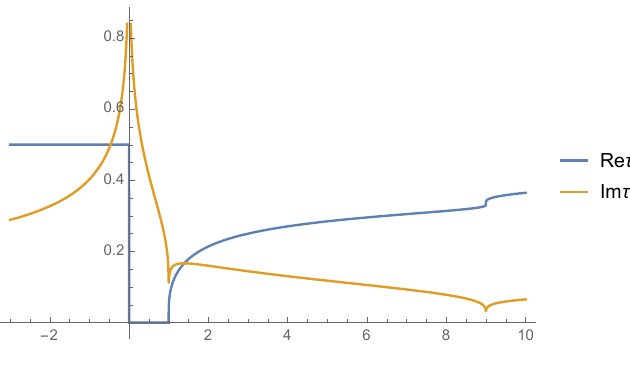
Figure 2. The real and imaginary parts of (cid:28)